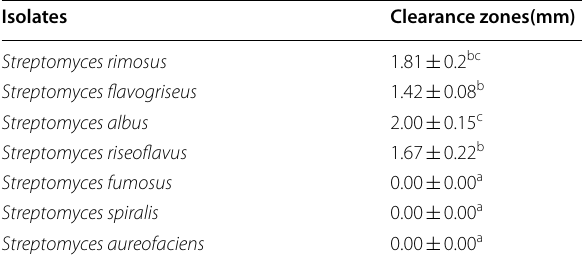
Table 4 Zone of inhibition of the Streptomyces species isolated from grassland soils sample on chitin mineral salt medium Isolates